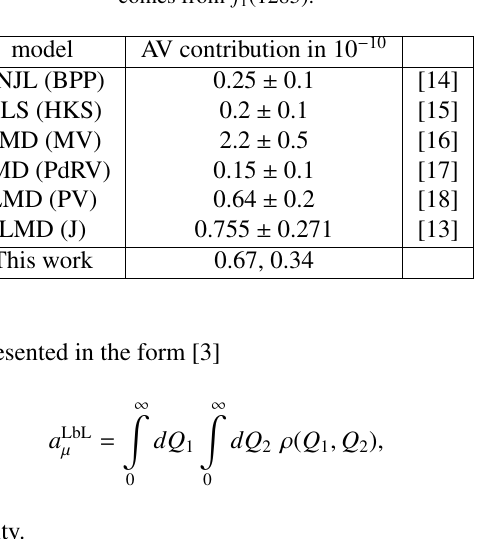
Table 1. Contribution to (g-2) of muon from axial-vector meson exchanges. Most of contribution comes from f 1